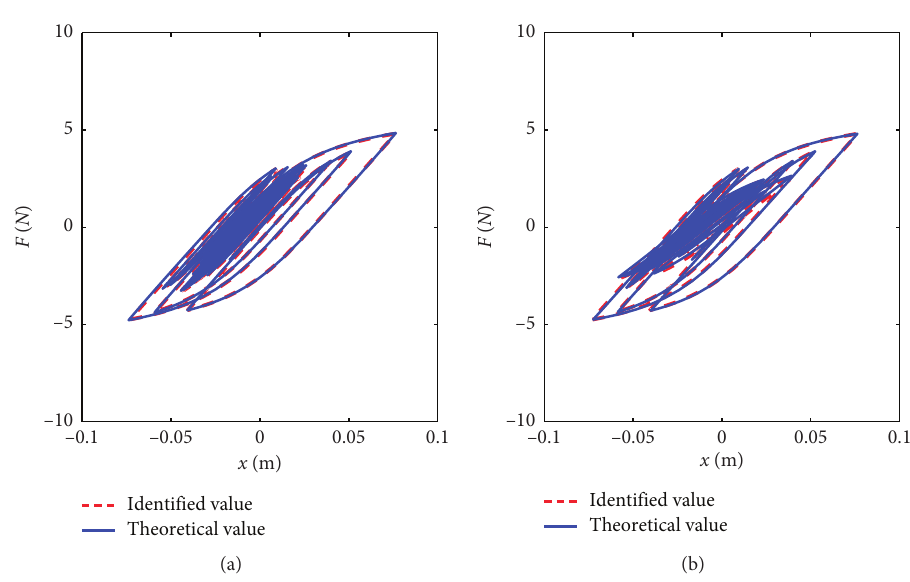
Figure 19: Comparison of hysteresis loops under EI-Centro earthquake wave. (a) Case 1. (b) Case 2.